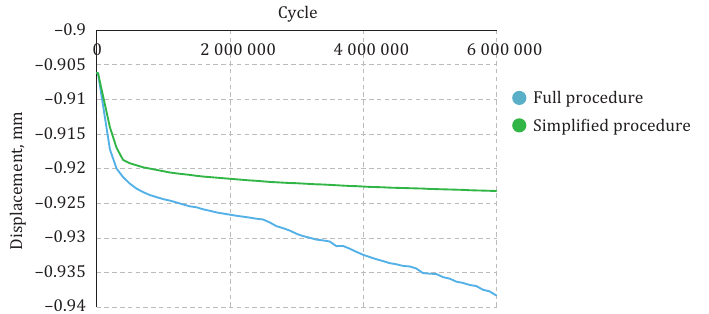
Figure 8. Dependence of vertical displacement on loading cycles